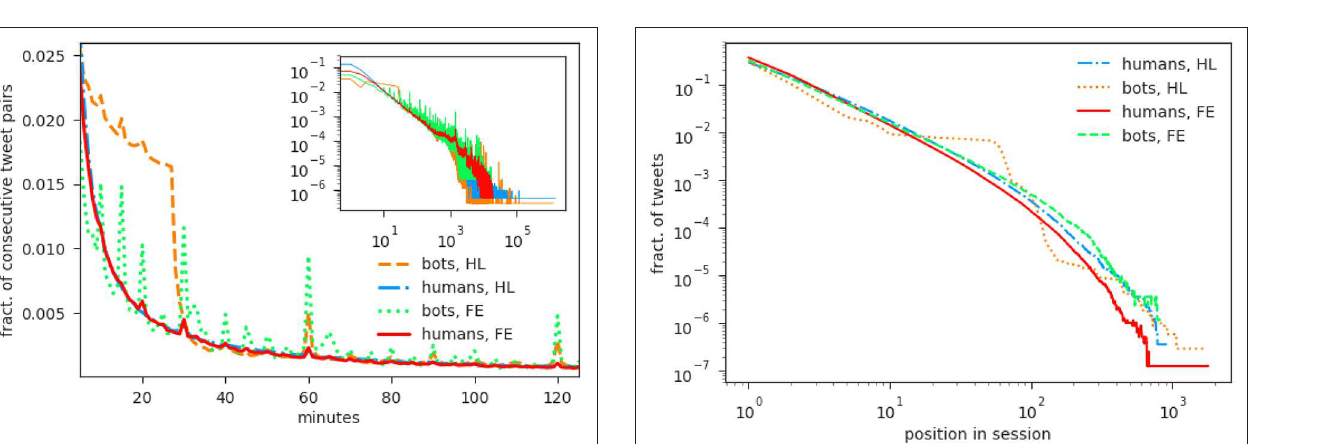
(left) and HL (right) data, to account for the different nature of the two datasets and at the same time to better highlight the behavioral analogies within each group of users. For every measure we plot the mean with its standard